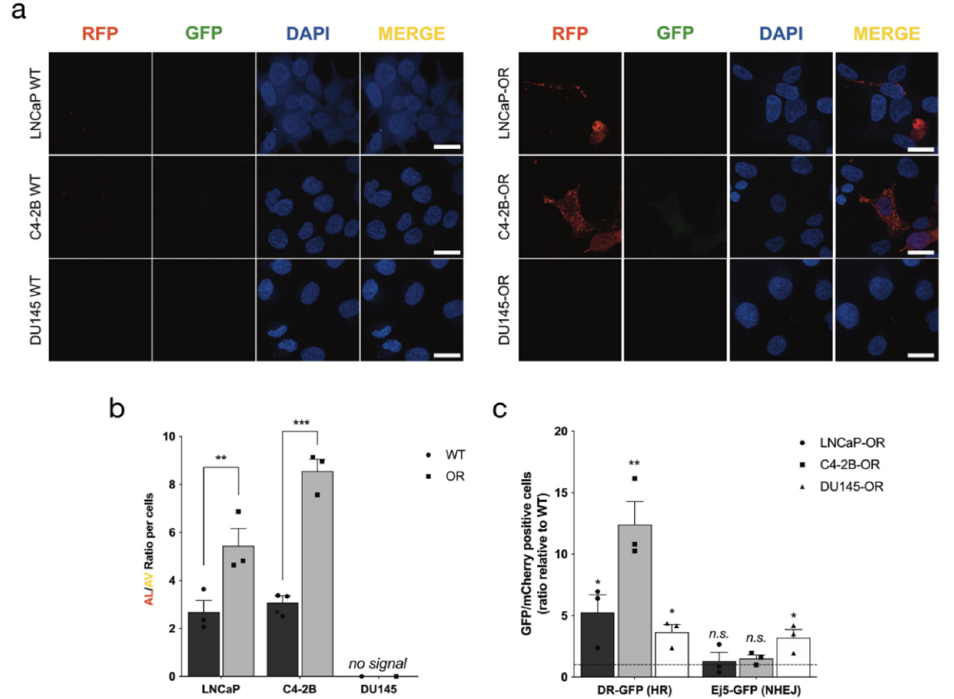
Figure 4. Autophagy and HR efficiency are upregulated in PC-OR cell lines. ( a ) Representative images of autophagy flux with the tandem RFP-GFP LC3B sensor in WT and OR PC cell lines, captured by confocal microscopy. ( b ) Quantification of ( a ) using ImageJ software to calculate the ratio between autolysosomes (AL; red puncta) and autophagosomes (AV; yellow puncta) relative to control. ( c ) Ratio of HR (DR-GFP) and NHEJ (Ej5-GFP) efficiency by flow cytometry compared to respective PC WT. For all data, the mean ± SEM of three independent experiments is shown. Data were analyzed using the two-tail Student t -test. n.s. = nonsignificant. * p < 0.05, ** p < 0.01 and *** p <